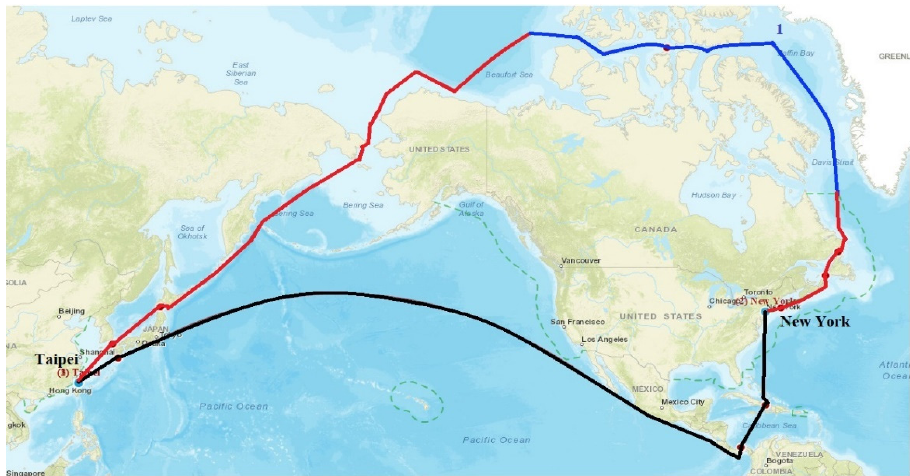
Figure 2. Routes along the Americas sea route (black) and Northwest Passage (red and blue). The Northwest Passage comprises one area (blue).